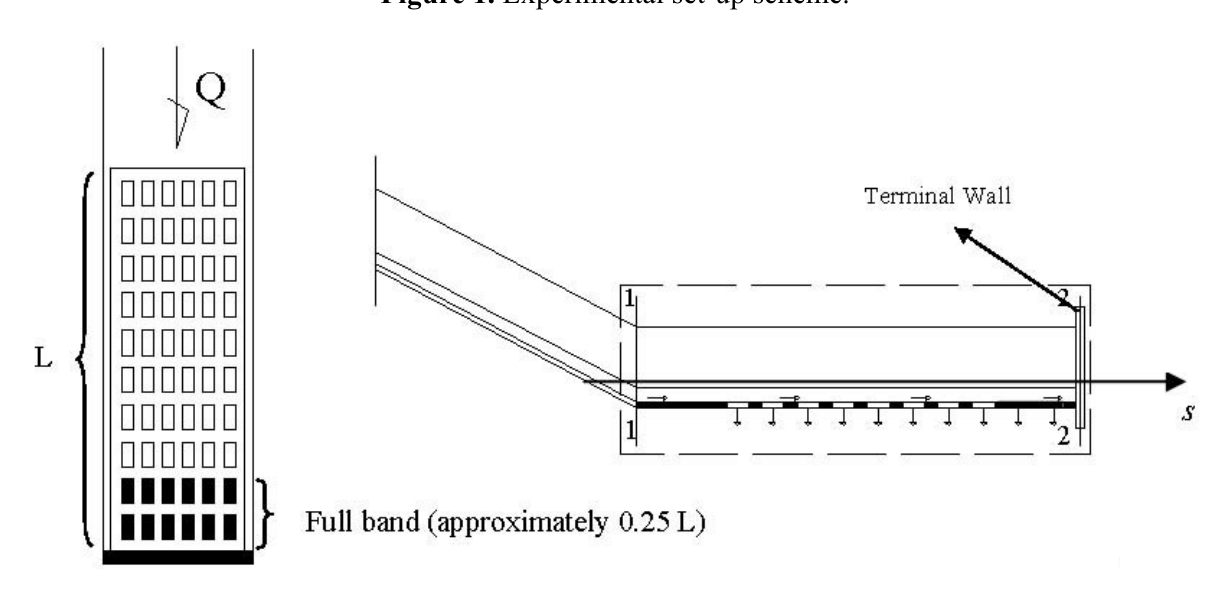
Figure 1. Experimental set-up